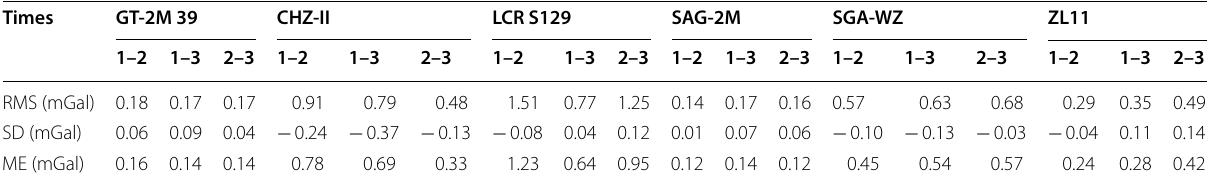
Table 2 Error statistics of different gravimeters on the repeated line L1 Times GT-2M 39